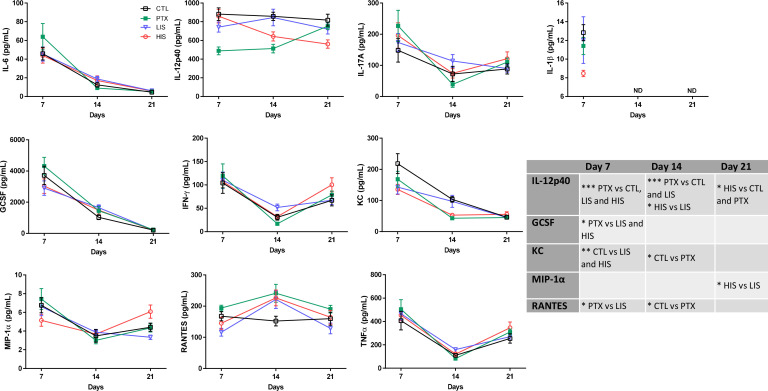
Time-course evaluation of inflammatory plasma cytokines and chemokines.Blood of mice treated with complete Freund’s adjuvant (CTL) in addition to MOG35-55 with PTX (PTX group) or without PTX (HIS and LIS groups) was harvested 7, 14, and 21 days post MOG35-55/CFA injection. Plasma cytokines and chemokines IL-1β, IL-6, IL-12(p40), IL-17, TNFα, IFNγ, MIP-1α, RANTES, KC and G-CSF were quantified using a Bio-Plex Multiplex kit. Data are mean ± sem. Two-way ANOVA with Dunnett’s post-hoc test. Statistical significance, if present, is shown in the table. *p≤0.05, ** *p≤0.01, *** *p≤0.001.